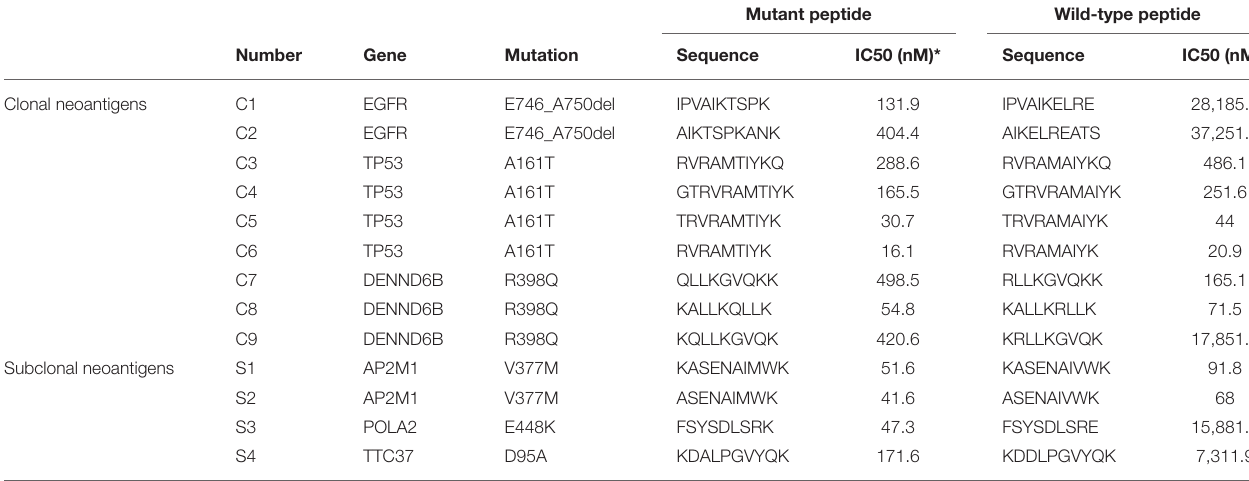
TABLE 1 | HLA-A * 11:01 restricted candidate neoantigens validated in IFN- γ ELISPOT assay.